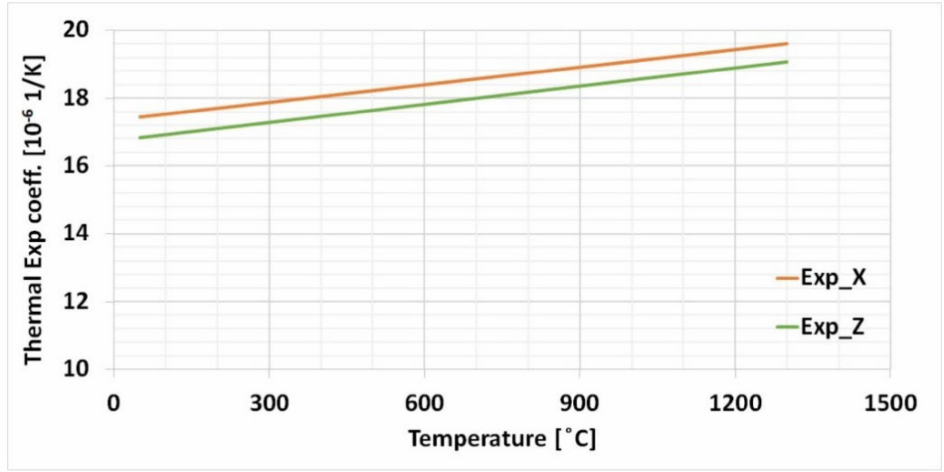
Figure 7. Elongation of sample during heating and cooling phase. The 3DExperience software requires total or average thermal expansion. Average elon- gation was calculated, and the regression polynomials were fitted for the two samples data. Strain from regression polynomials for the corresponding temperature were calculated. Total or average thermal expansion was calculated using the following equations for all corresponding temperatures.